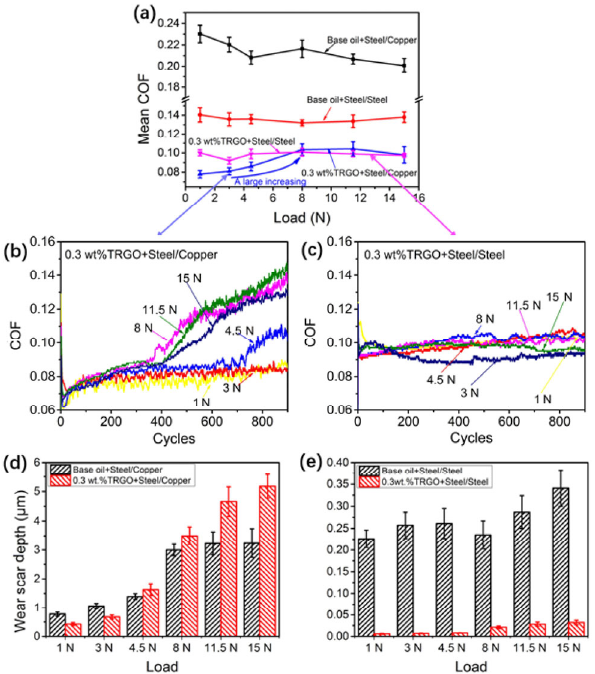
Fig. 3 Coefficients of friction (COFs) and wear scar depths of 0.3 wt% TRGO lubricant and the base oil for (b) and (d) the steel/copper and (c) and (d) steel/steel friction pairs: (a) the mean COFs of 0.3 wt% TRGO lubricant and the base oil as functions of load; (b) and (c) the trends in COFs of 0.3 wt% TRGO lubricant over sliding time; (d) and (e) the wear scar depths of TRGO lubricant and the base oil.